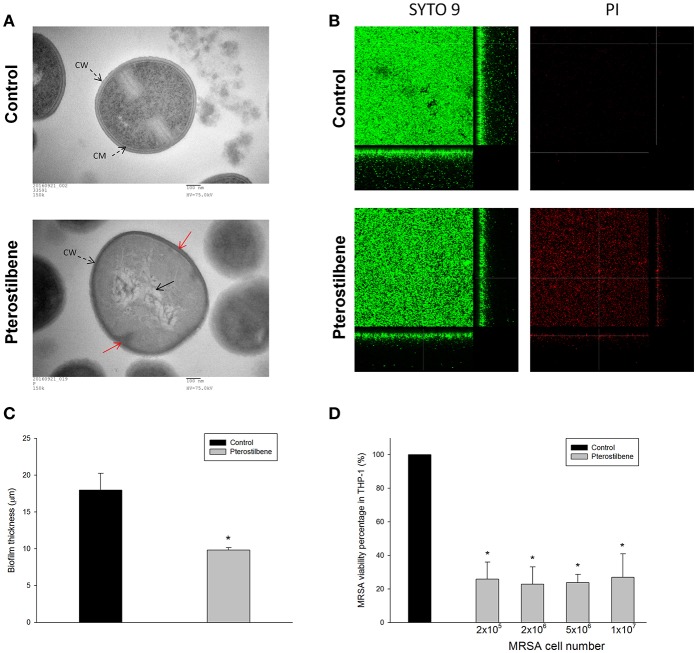
Anti-MRSA activity of pterostilbene: (A) Morphological changes of MRSA viewed under TEM, (B) the three-dimensional images of biofilm, (C) the corresponding biofilm thickness, and (D) intracellular MRSA killing in macrophages (THP-1). Each value represents the mean and S.D. (n = 4).